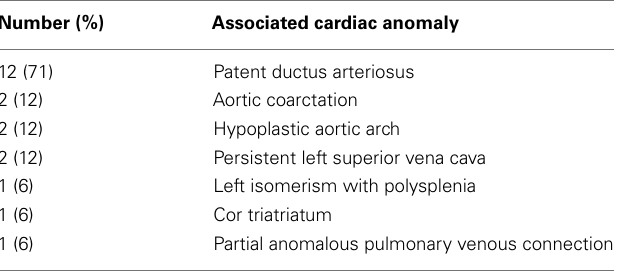
Table 1 |Associated cardiac